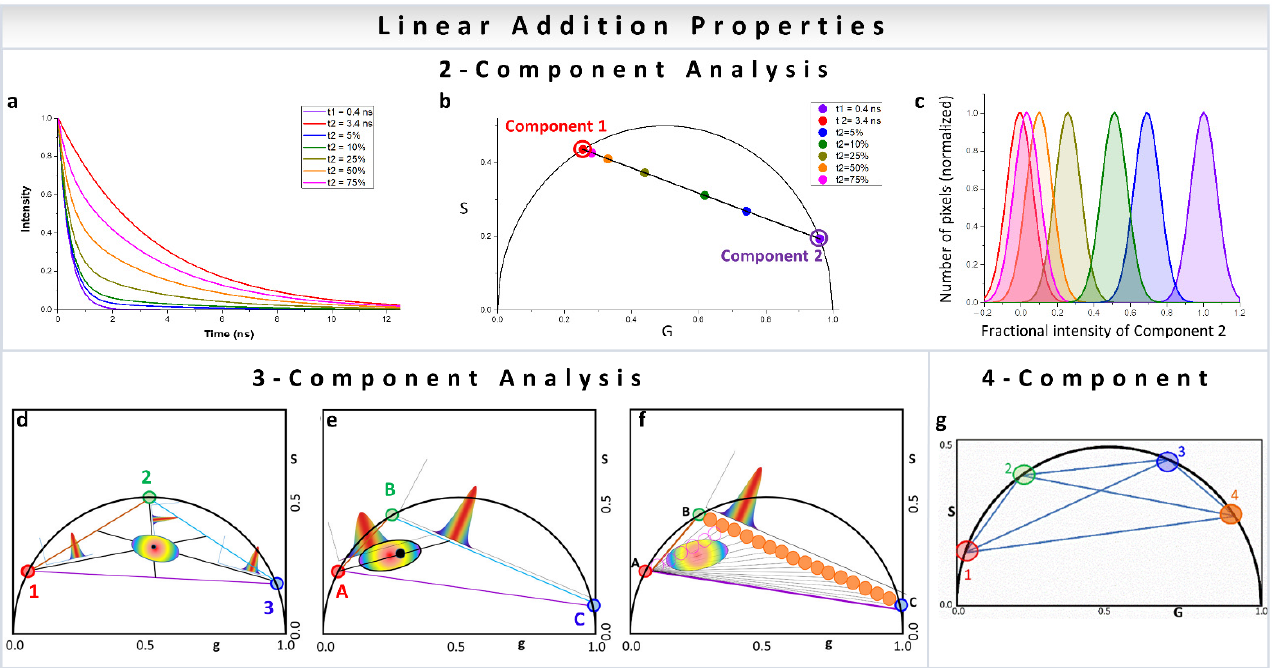
Figure 2. Multicomponent analysis in phasor plot. ( a – c ) Two-component analysis using phasor approach. ( a ) The intensity decays were calculated using the lifetime of free NADH (0.4 ns, violet) and protein-bound NADH (3.4 ns, red). Different fractions of free to bound NADH were used for calculating the decays in the middle. In increasing percentage of bound NADH—5% (blue), 10% (green), 25% (yellow-green), and 50% (orange). ( b ) The corresponding phasor positions were calculated, and they appear along the metabolic trajectory [18], connecting the positions of free (violet) and bound (red) NADH. Two-component analysis allows the distribution along the line joining the phasor positions of the individual components to be calculated, as exemplified by free and protein-bound NADH here. However, this is valid for any two original phasor components. ( d – f ) Three-component analysis using phasor approach. ( d ) The lines joining the individual cursor positions (red, blue and green), forming the vertices of the triangle and the phasor point whose fractional intensity contributions are being calculated (black), are extended to the opposite side of the triangle. The distances of the vertices from the black point are used for the calculation of fractional intensity contribution (the graphs). ( e ) Calculation of three components where two components are related, e.g., free and protein-bound NADH. In this case, the presence of the third component shifts the distribution towards that third component and away from metabolic trajectory. This distance can be converted to the fractional intensity of free NADH and plotted (the graph between green and blue points) or fractional intensity of third species (the graph along the line joining the red vertex and the opposite line). ( f ) Graphical analysis of three components. A cursor of a given size is scanned along point A and another point in line BC to calculate the fraction of the third component along the axis and then this process is combined for different points on BC to create the fraction of the third component. The number of points along each of these black lines are counted by scanning (orange cursors) and plotted along the coordinates of BC to calculate the fraction of free NADH. (Panels d – f adapted with permission from [32]). ( g ) Four-component analysis using phasor approach. Representation of four species with different phasors indicated by the number 1 to 4 (1, red; 2, green; 3, blue; 4, orange). In this case, the individual species are single exponentials since they are on the universal semicircle. The position of a phasor point in a single harmonic inside this quadrangle can be defined by multiple triangles. Multiple harmonics are needed to obtain unique solution for the contribution of the four components. (Panel g adapted with permission from [35]).